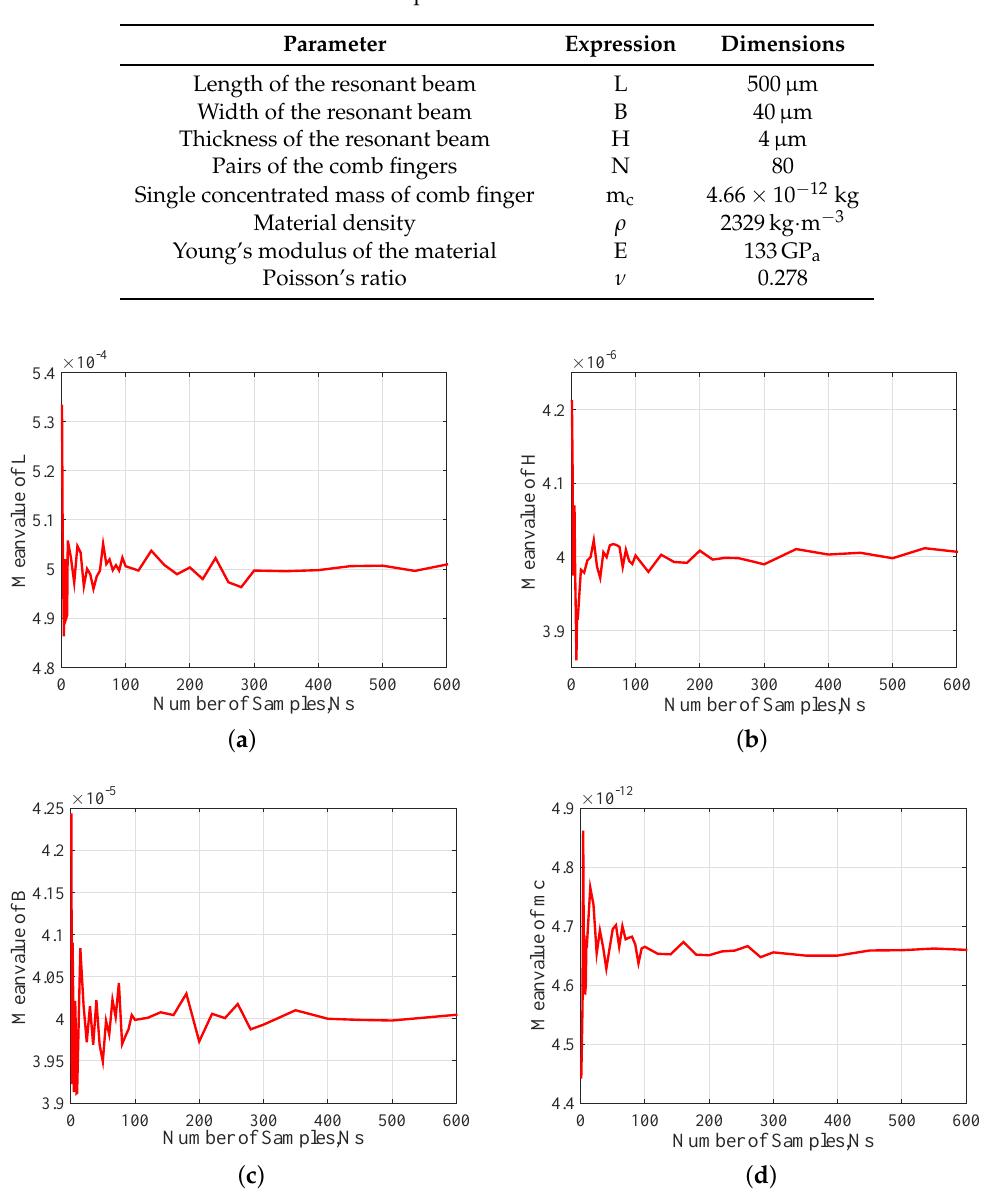
Figure 6. Stochastic convergence analysis of Mean value of input parameters: ( a ) L, ( b ) B, ( c ) H and ( d ) m c